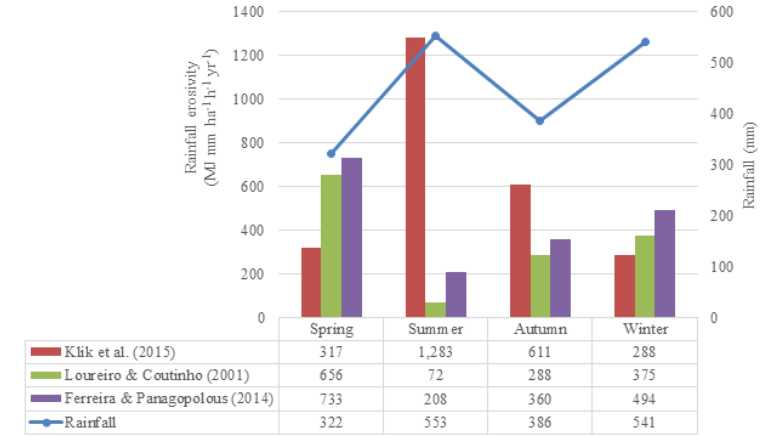
Figure 1. Graph of seasonal rainfall and estimates of erosivity in the Mangatarere watershed (Benavidez, 2018). Table 1. Annual estimates (Benavidez, 2018) of erosivity in the Mangatarere watershed (megajoule millimetres per hectare per hour per year). Equation source Klik et al. (2015) Loureiro and Coutinho (2001) Ferreira and Panagopolous (2014)